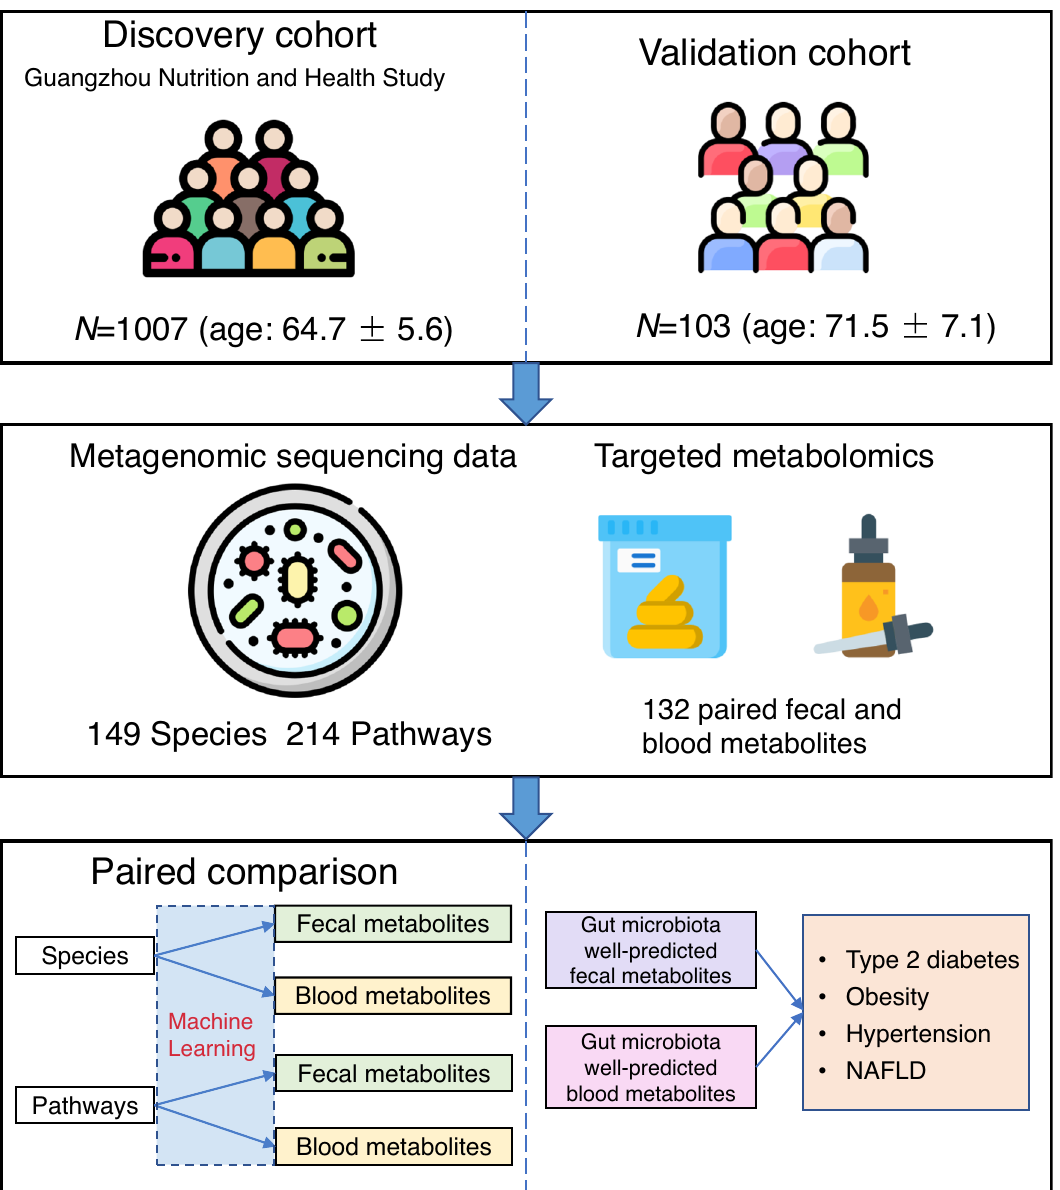
Fig. 1 | Work fl ow of the present study. A total of 1007 participants from the Guangzhou Nutrition and Health Study with matched gut metagenomic and fecal and blood metabolomics data and without taking antibiotics within two weeks are included in this study. Shotgun metagenomic sequencing is performed for fecal samples to obtain the metagenomic data, including taxonomic composition and microbial pathways. A targeted metabolome pro fi ling is performed to obtain the fecalandbloodmetabolomicsdata.Afterremovingmetaboliteswithmissingrate